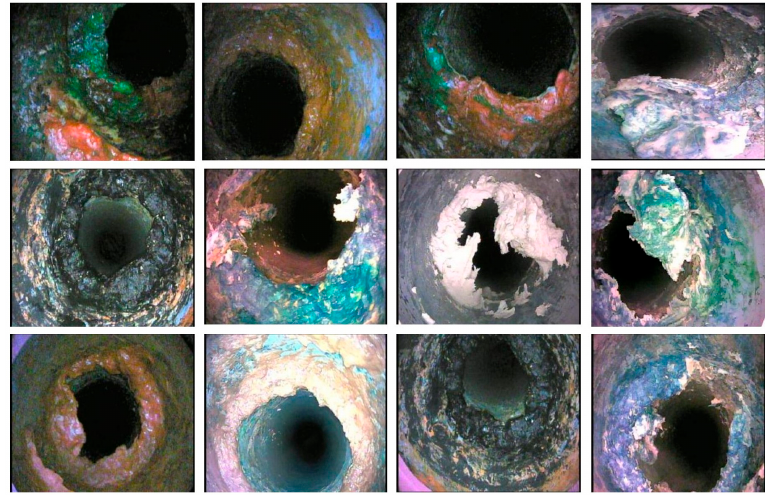
Figure 6. Plastic blockage frames in the S-BIRD dataset.